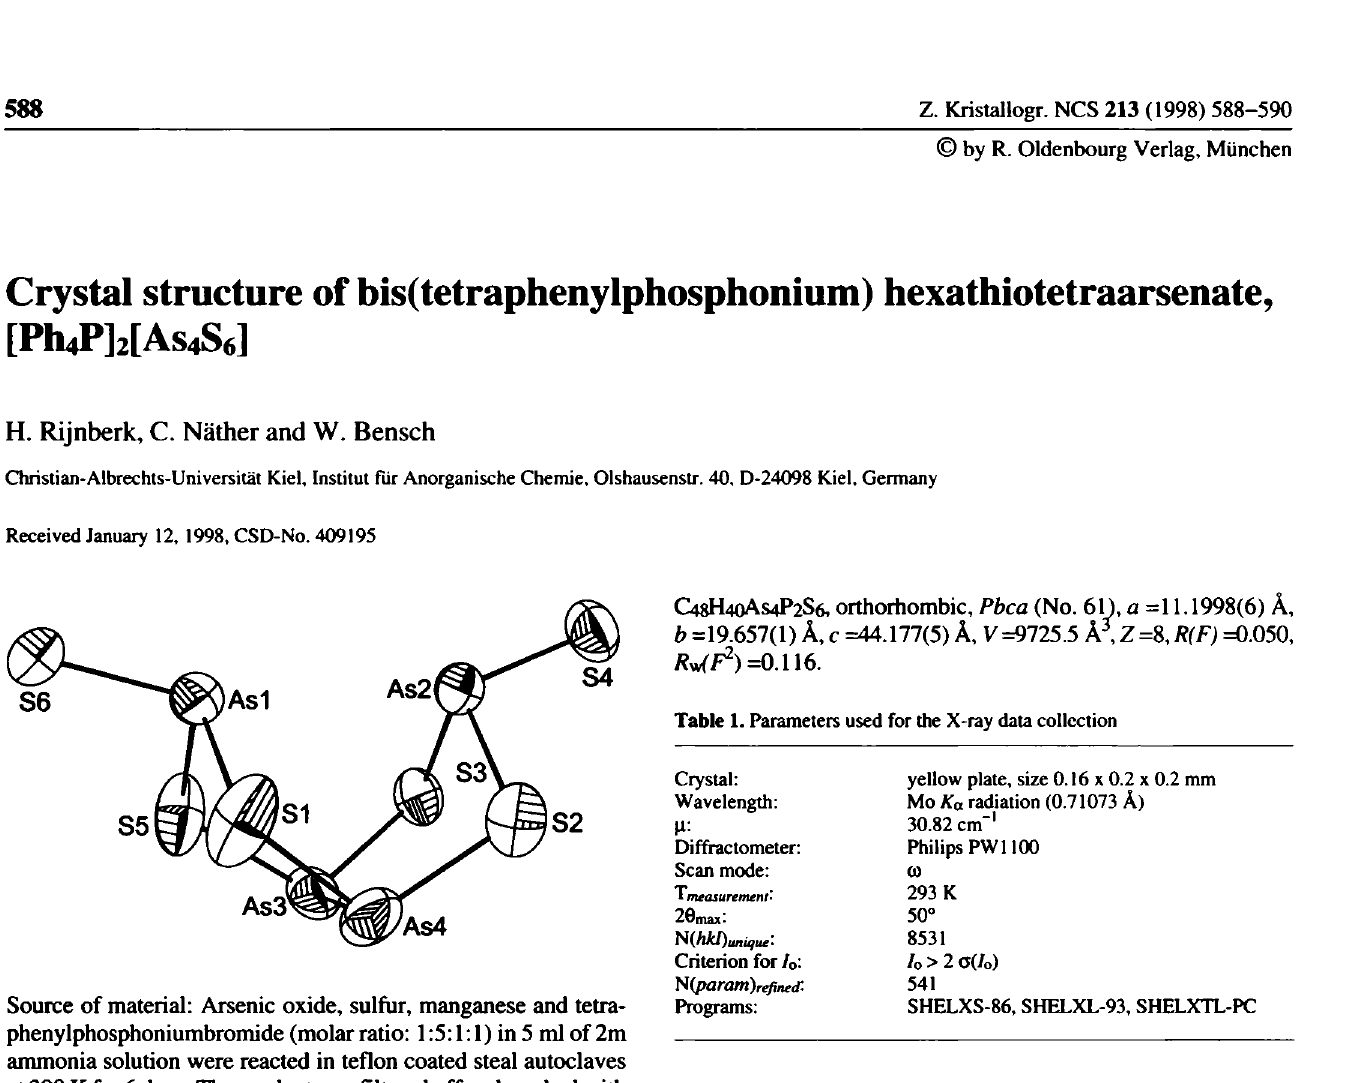
Table 2. Final atomic coordinates and displacement parameters (in